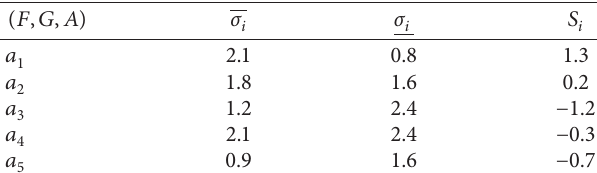
, a ,a , a , a 1 2 3 4 5